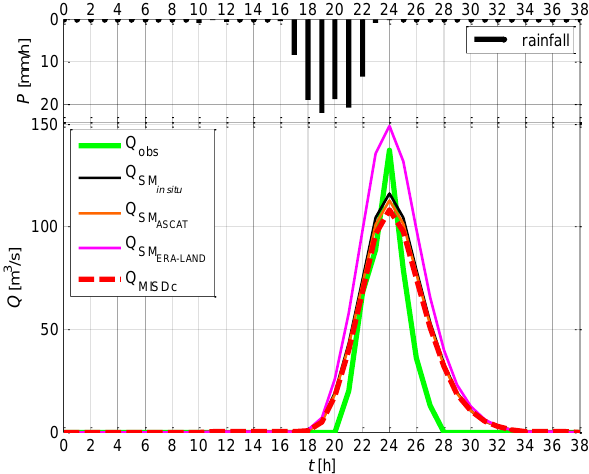
Figure 6: Validation of the event of 21-Feb-2013 at Rafina gauged site. Comparison between observed Q obs 2 Fig. 6. Validation of the event of 21 February 2013 at the Ra- and predicted flood hydrographs using SCRRM with in situ data (Q SM in situ ), ASCAT data (Q SM ASCAT ), ERA- 3 Land data (Q SM - ERA-LAND ) and MISDc (Q SM - MISDc ). 4 fina gauged site. Comparison between observed Q obs and predicted flood hydrographs using SCRRM with in situ data ( Q SM CAT data ( Q SMASCAT ), ERA-Land data ( Q SM-ERA-LAND ) and MISDc ( Q SM-MISDc